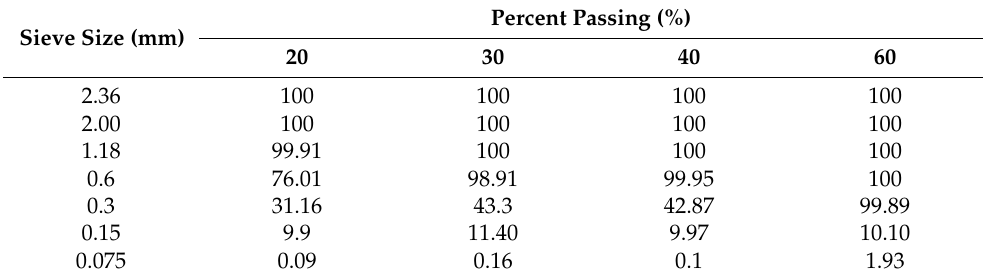
Table 3. Particle size distribution of crumb